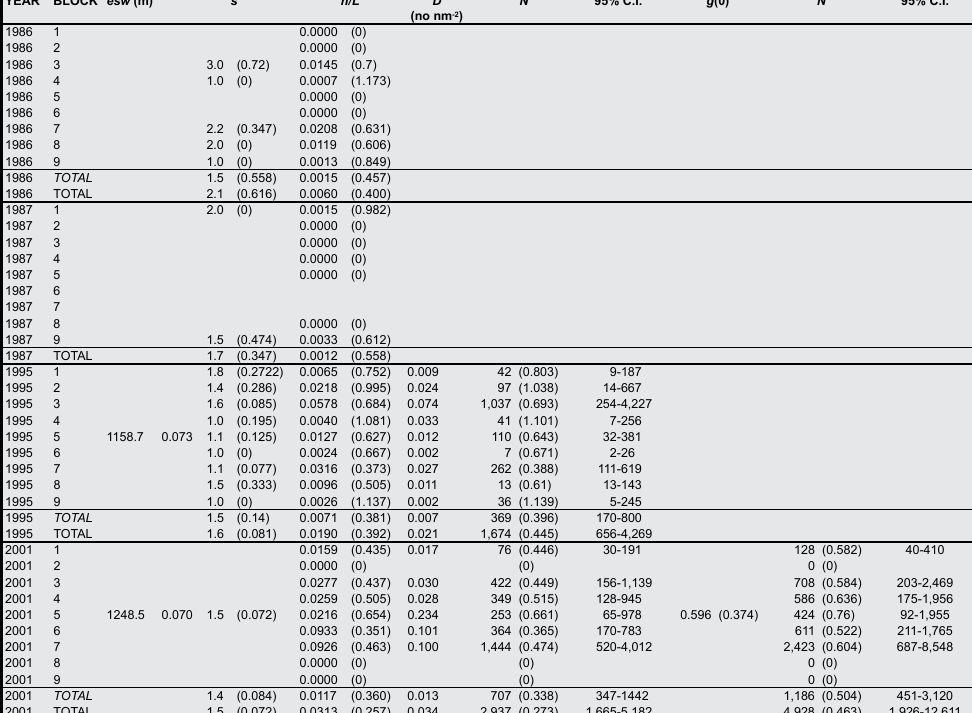
Table 5. Abundance estimates of humpback whales from Icelandic aerial surveys, 1986-2001. N’ – uncorrected abundance estimate; g (0) – proportion of visible whales on the trackline seen by primary platform observers; N – abundance estimate, corrected for g (0). Others as in Table 4. YEAR BLOCK esw